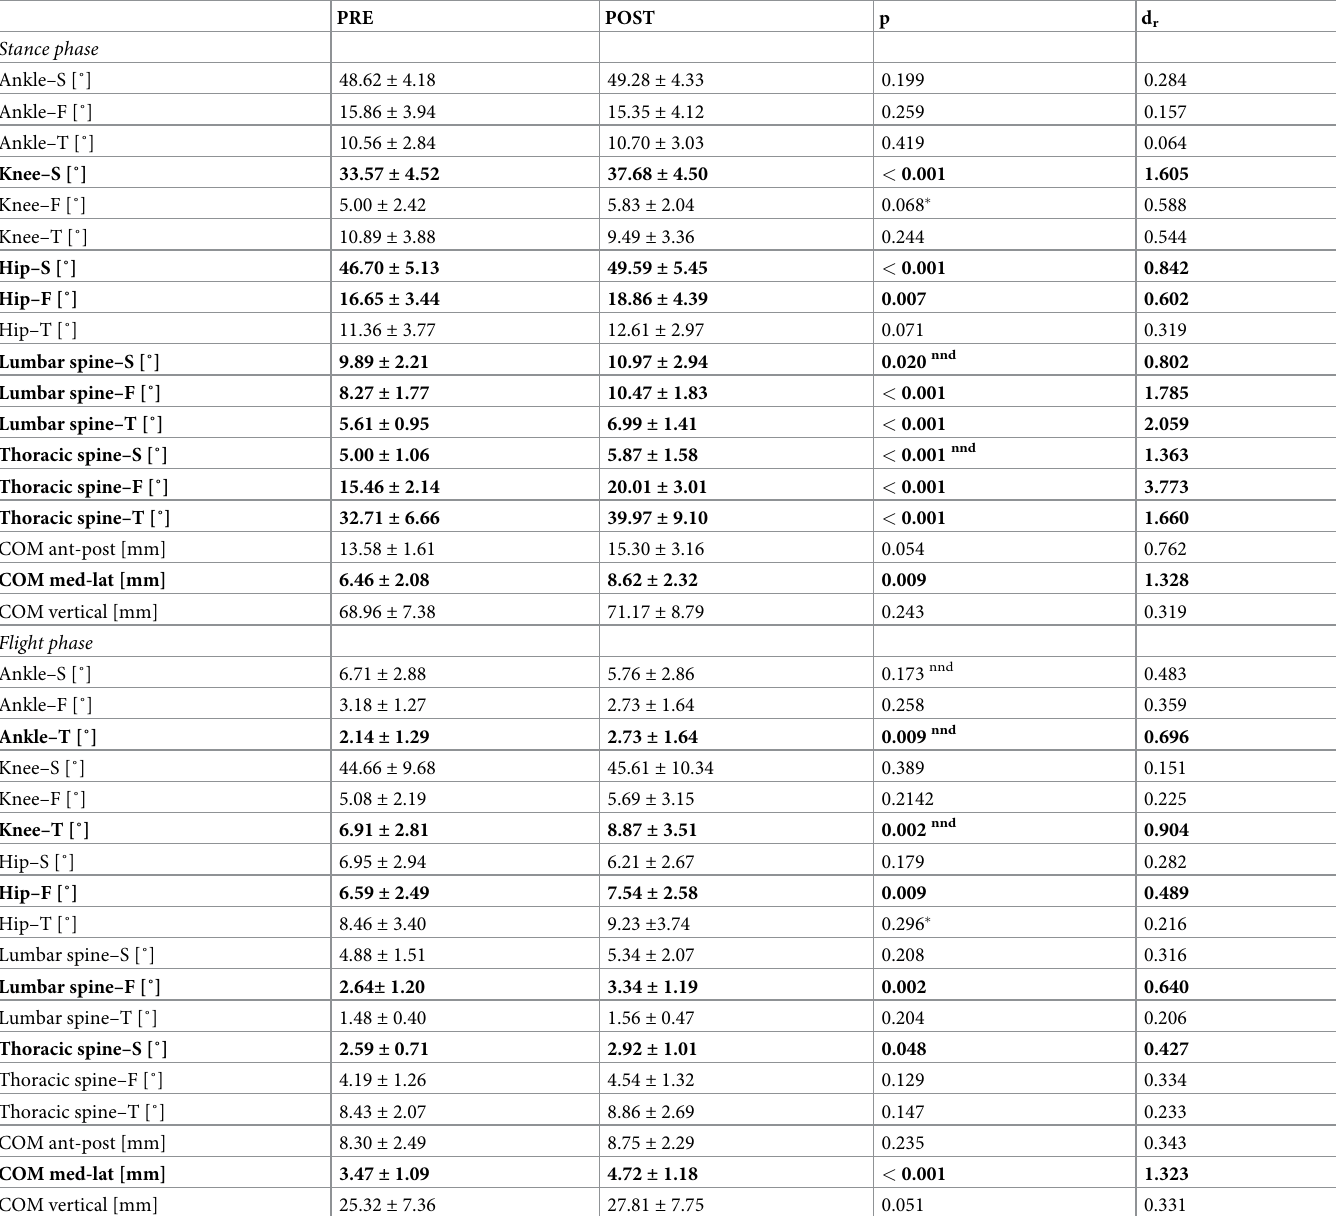
Table 3. Mean ± standard deviation of the RoM of joints in degrees (˚) and of the CoM in mm are shown for stance and flight phases separately. PRE POST d